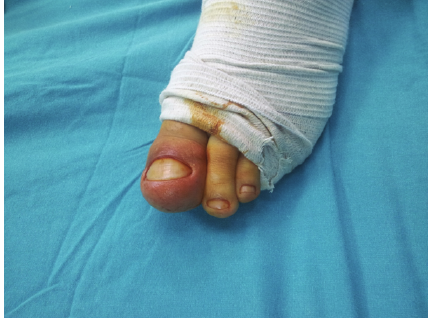
Figure 1: Preoperative clinical photograph of the left great toe.